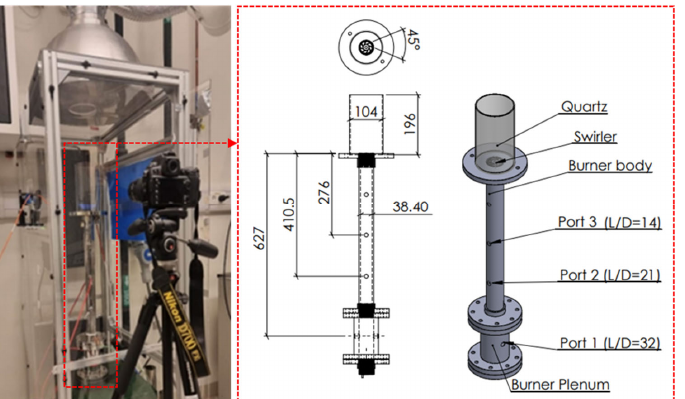
Figure 1. Experimental setup and schematic of the swirl burner (all dimensions in mm).